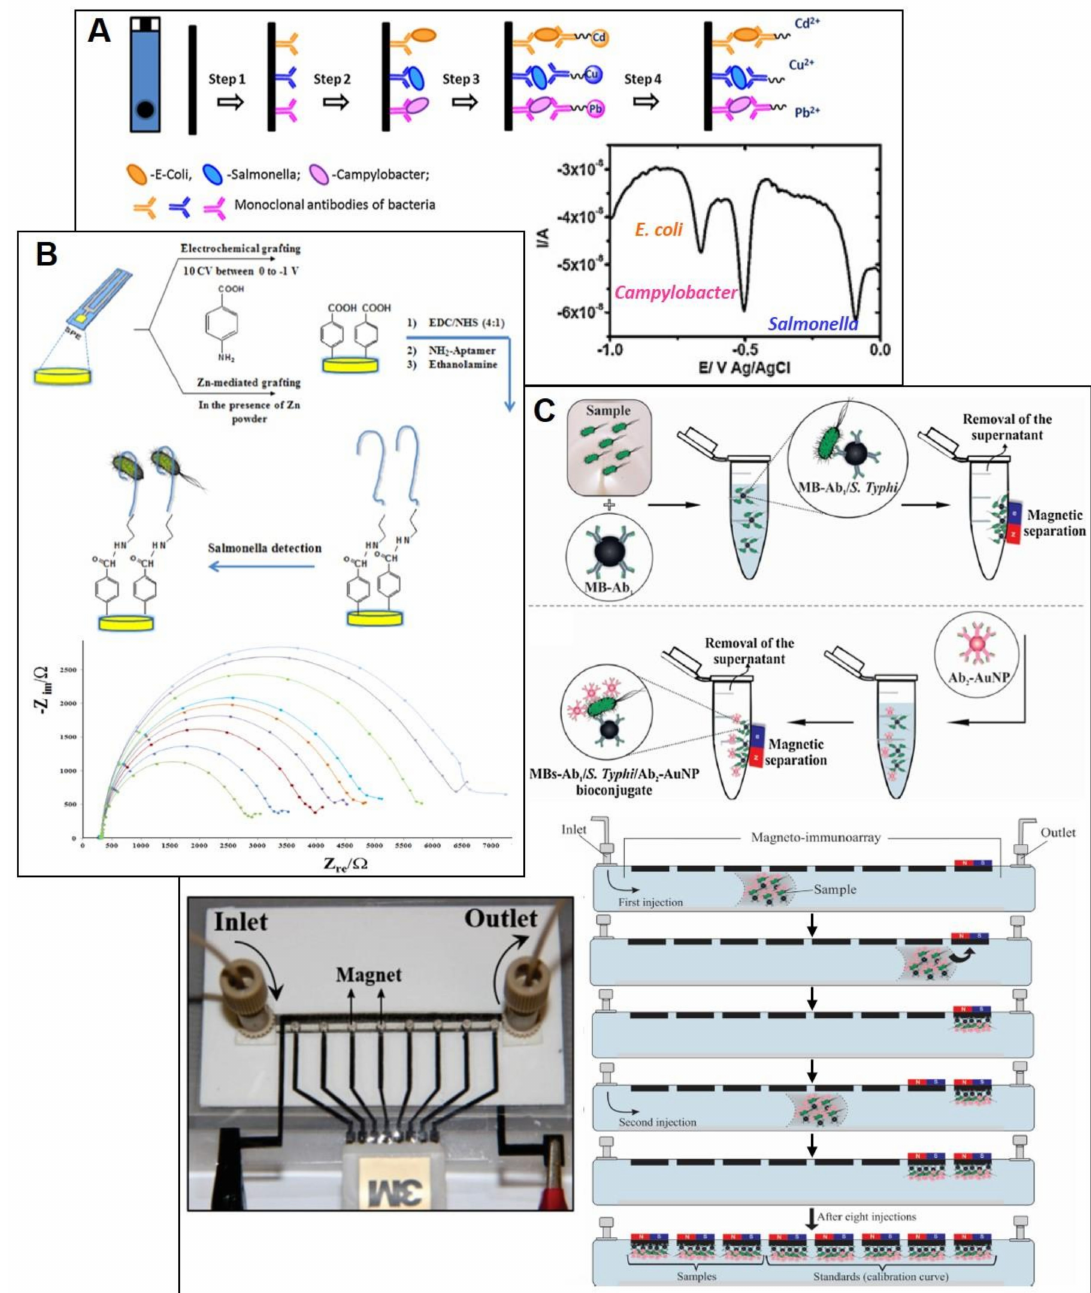
Figure 4. ( A ) Schematic representation of the multiplexed immunosensor developed by Viswanathan et al. for E. coli , Salmonella , and Campylobacter detection and the analytical signals obtained for the three bacteria by square-wave anodic stripping voltammetry (SWASV). Reproduced from [78] with permission from Elsevier. ( B ) Schematic representation of the aptasensor developed by Bagheryan et al. for Salmonella detection and the electrochemical impedance spectroscopy (EIS) signals obtained for di ff erent Salmonella concentrations included in the calibration curve. Reproduced from [73] with permission from Elsevier. ( C ) Schematic representation of the immunoassay based on magnetic beads developed by T.R. de Oliveira et al. using the microfluidic multiplex system shown in the picture. Reproduced from [75] with permission from